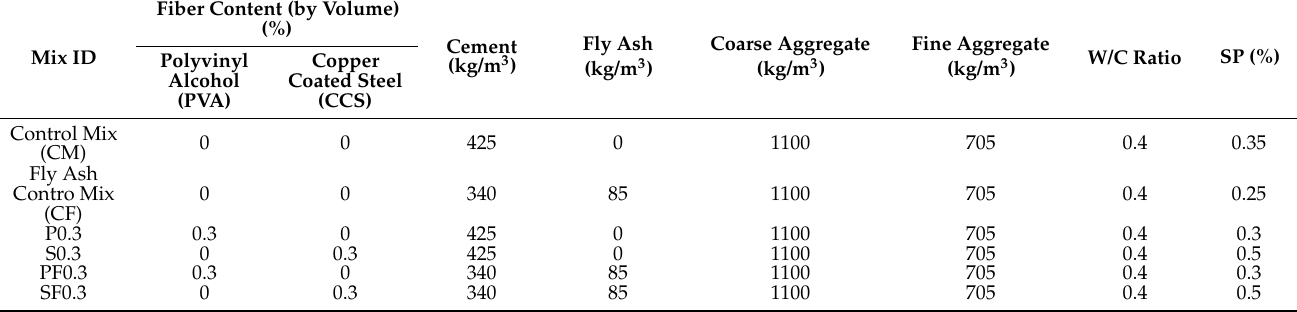
Table 2. Details of concrete mix proportions.